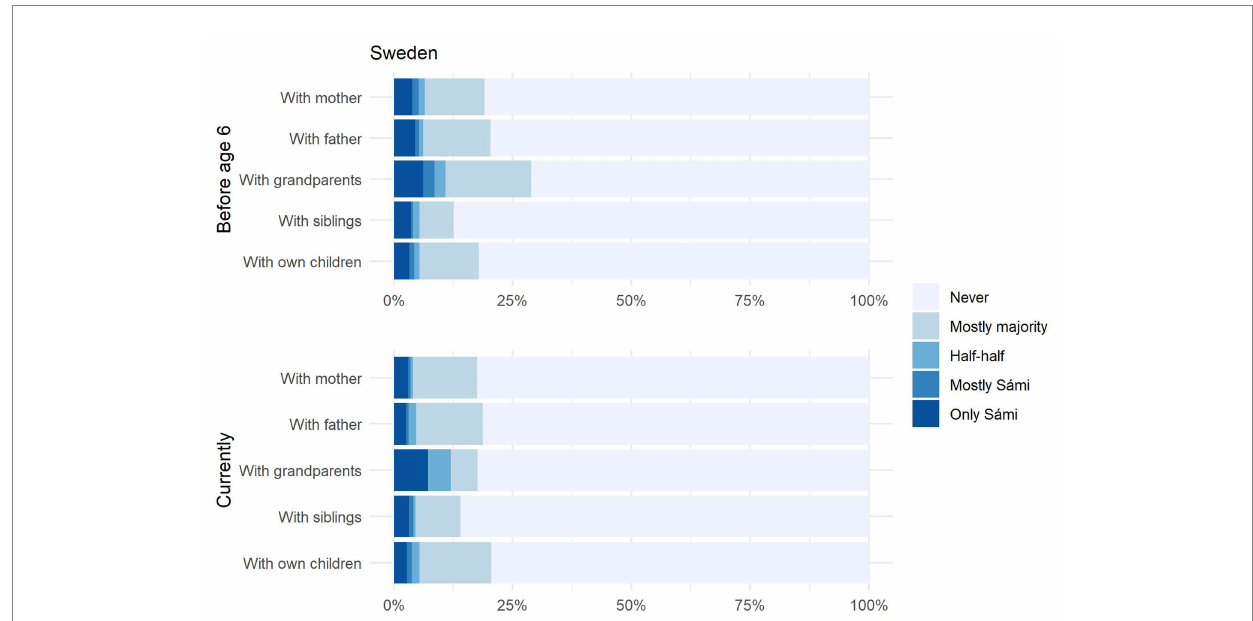
FIGURE 5 Sweden: Amount of Sámi spoken by family member before starting school vs. currently.